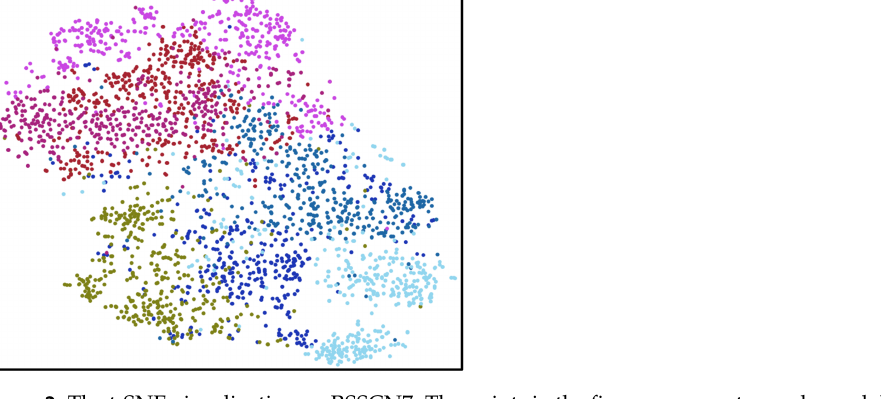
Figure 2. The t-SNE visualization on RSSCN7. The points in the figure represent samples and different colors represent different classes. It can be found that the samples of the same classes are scattered, and show a local